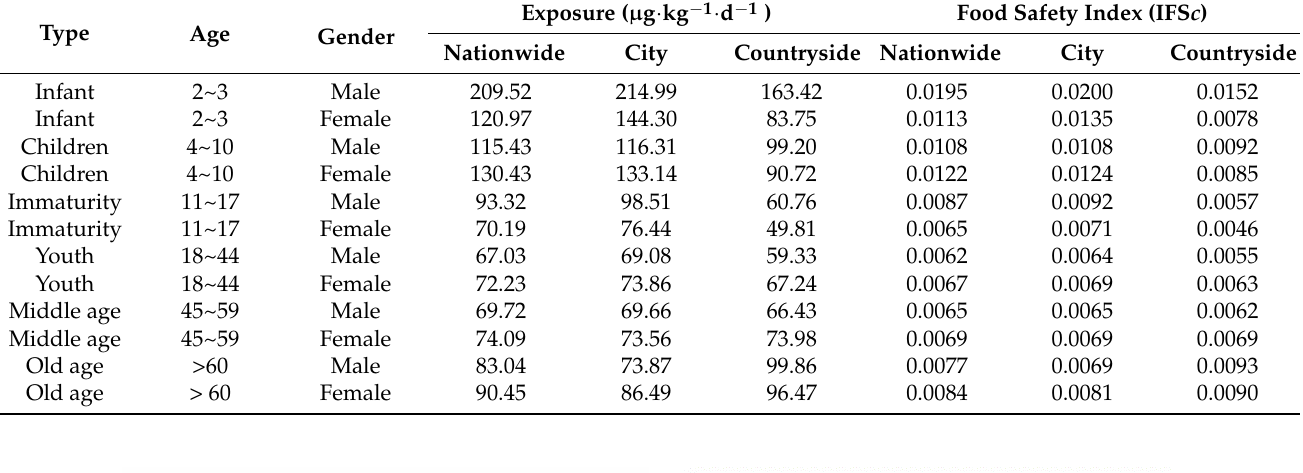
Table 4. Dietary exposure and food safety index of total biogenic amines.